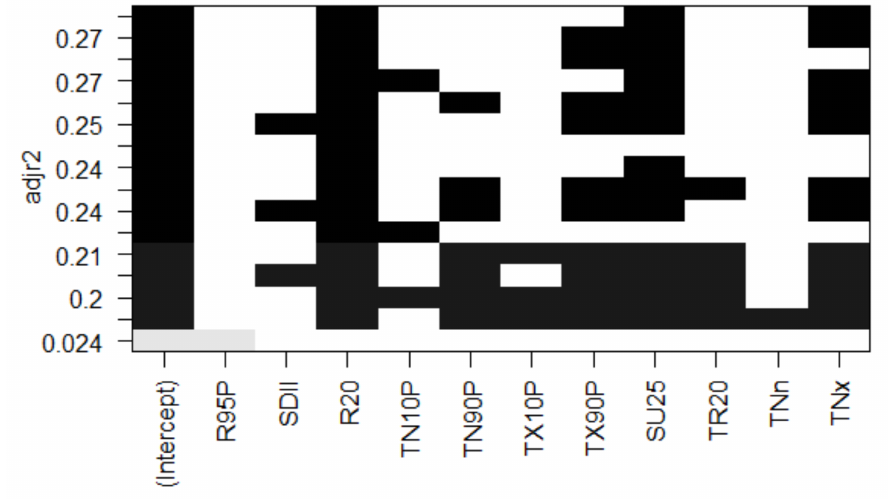
Figure 9. Full subset regression